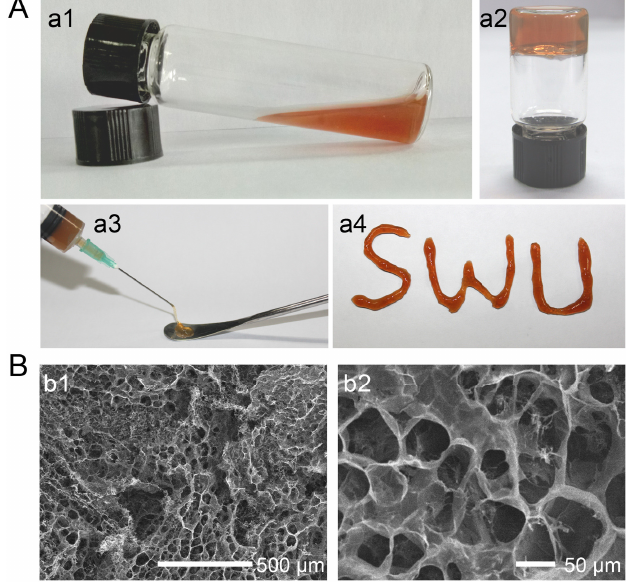
Figure 9. SA/Se–Ag (alginate/sericin–silver) hydrogels and SEM images. ( A ) Photos of SA/Se–Ag hydrogels without ( a1 ) or with ( a2 ) calcium ions. SA/Se–Ag hydrogels were injectable ( a3 ) and moldable ( a4 ). ( B ) Low ( b1 ) and high ( b2 ) magnification FESEM images of SA/Se–Ag0.2 hydrogel. Reprinted with permission from [145].